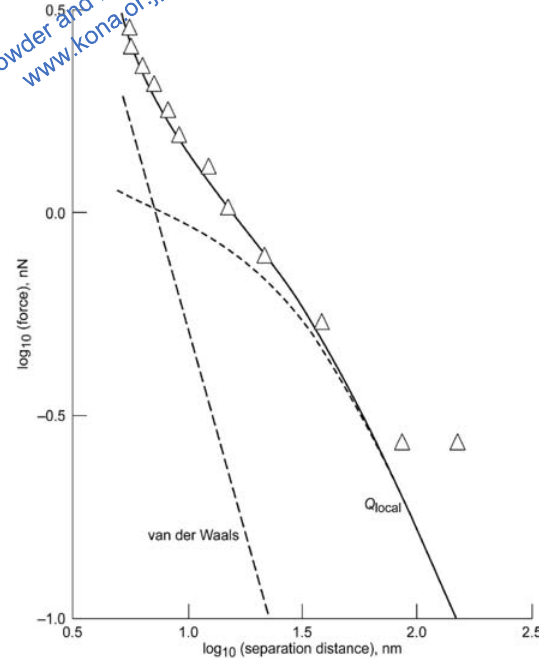
Fig. 3 AFM-measured force-displacement for a triboelectrically charged 3 μ m polystyrene sphere near an atomically flat HOPG substrate (symbols), van der Waals force (i.e ., Eqn. 5) (dashes), and a local charged-patch (of a JKR-contact-spot size, i.e ., Eqn 17) with Q L adjusted to best fit the data (dotted line). Solid line is sum of van der Waals and charged-patch curves [Gady et al,